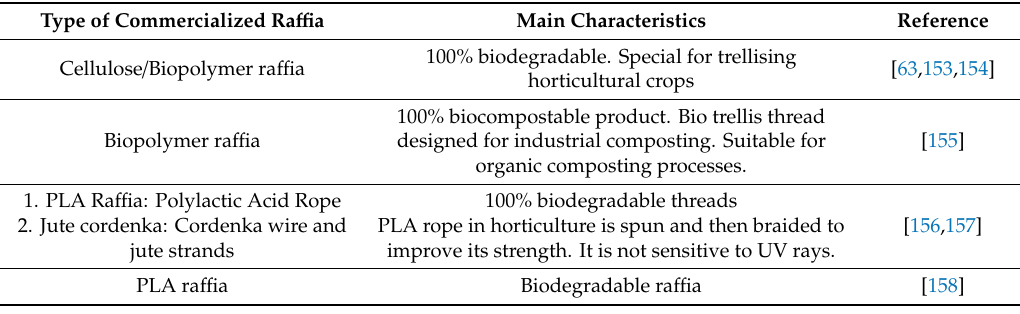
Table 3. Main types of commercialized biodegradable ra ffi